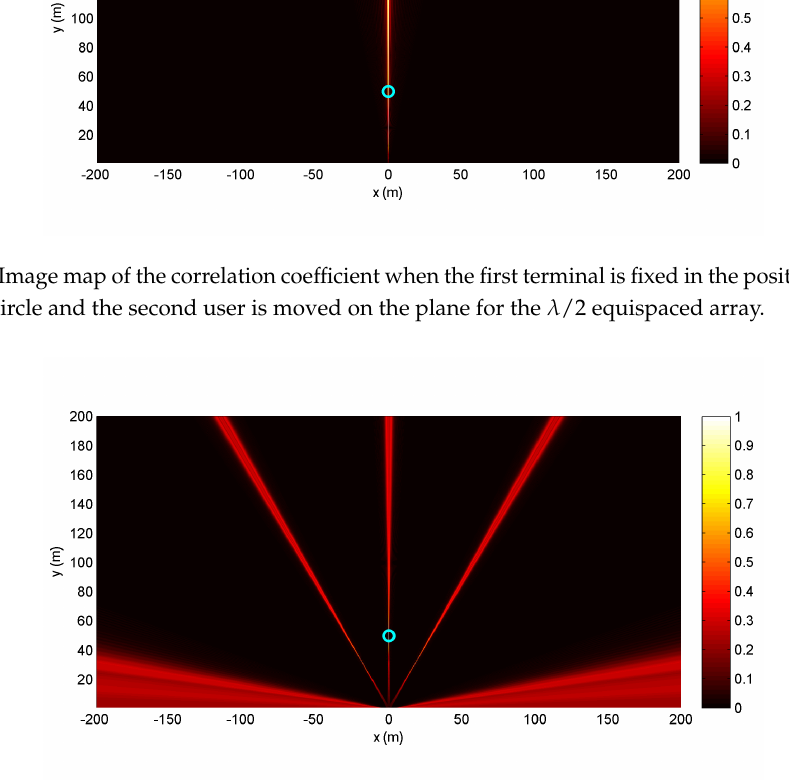
Figure 5. Image map of the correlation coefficient when the first terminal is fixed in the position marked with the circle and the second user is moved on the plane for the 2 λ equispaced